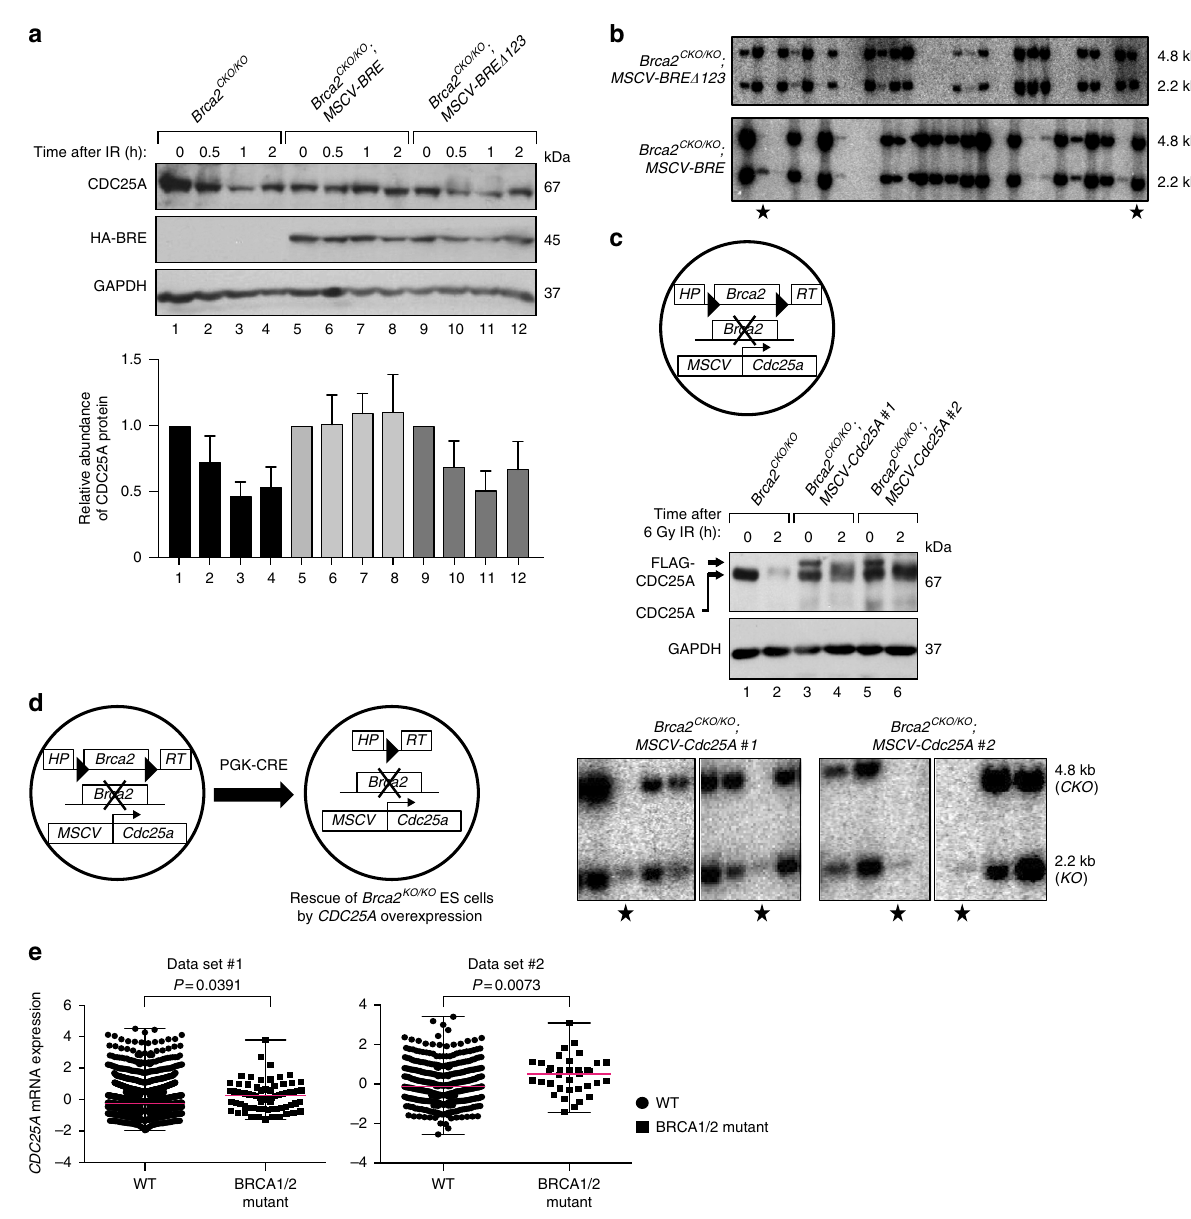
Fig. 5 CDC25A overexpression can rescue ES cell lethality of Brca2 KO/KO . a Immunoblot showing IR-induced degradation of CDC25A in PL2F7 mES cells expressing either HA-BRE or HA-BRE mutant defective in USP7 binding (FL Δ 123). GAPDH was used as control. The histogram below shows the average relative abundance of CDC25A at particular time points from three independent experiments. All intensities were normalized against corresponding GAPDH band intensities. Supplementary Table 2 shows the P values. b Representative Southern blot analysis showing the identi fi cation of Brca2 KO/KO cells (marked with solid stars) after CRE-mediated deletion of conditional allele in indicated cell lines. Upper band: conditional allele ( CKO ); lower band: knock- out allele ( KO ). c Western blot showing CDC25A abundance in Brca2 CKO/KO and Brca2 CKO/KO ; MSCV-Cdc25A ES cells before (lanes 1, 3, 5) and 2 h after 6 Gy IR (lanes 2, 4, 6). Top panel represents the scheme of expression of FLAG-CDC25A from MSCV LTR. GAPDH was used as a loading control. d Southern blot analysis of HAT-resistant ES cell colonies after CRE-mediated deletion of conditional allele in Brca2 CKO/KO ; MSCV-Cdc25A ES cells to identify Brca2 KO/ KO clones (marked with solid stars), upper band: conditional allele ( CKO ); lower band: knock-out allele ( KO ). e CDC25A mRNA expression in two different breast cancer data sets from The Cancer Genome Atlas (TCGA). Left panel represents the data set of METABRIC breast cancer with 2433 tumors and right panel shows the breast invasive carcinoma data set of 825 tumors. Dots or squares in graphs represent individual tumors. Middle line, median; whiskers, minimal and maximum values. Signi fi cance was calculated using unpaired t -test with Welch ’ s Methods GFP 69 . The pCDNA3.1+ (Invitrogen) vector was used for transient expression of Plasmids, antibodies, and reagents . MSCV-Cre plasmid was a kind gift from Dr. FLAG-Cdc25A, HA-BRE , and FLAG-DUB3 . For the expression of BRCC36, Ubi- quitin, USP7, catalytic inactive USP7, β -TRCP3, RAP80, MERIT40, and BRCA1 Dan Littman. HA epitope was tagged to the C-terminus of human BRE cDNA and pOZ-N-FH BRCC36 (Addgene #27496) FLAG-HA-BRCC3 (Addgene #22540), was cloned in to MSCVneo vector (Clontech #634401). To generate MSCV-Cdc25a HA-Ubiquitin (Addgene #18712), pQHA-USP7 WT puroR (Addgene #46753), expression vector, mouse Cdc25A cDNA was N-terminally fused with FLAG epi- pCI-neo-FLAG-HAUSP (Addgene #16655), pQHA-USP7 CS puroR (Addgene tope and cloned into MSCVneo vector (Clontech). For inducible expression of #46754), pTRCP3-Myc (Addgene #25902), pOZ-N-FH RAP80 (Addgene #27501), BRE, HA-tagged human BRE cDNA was cloned into vector pCCALL2-IRES-